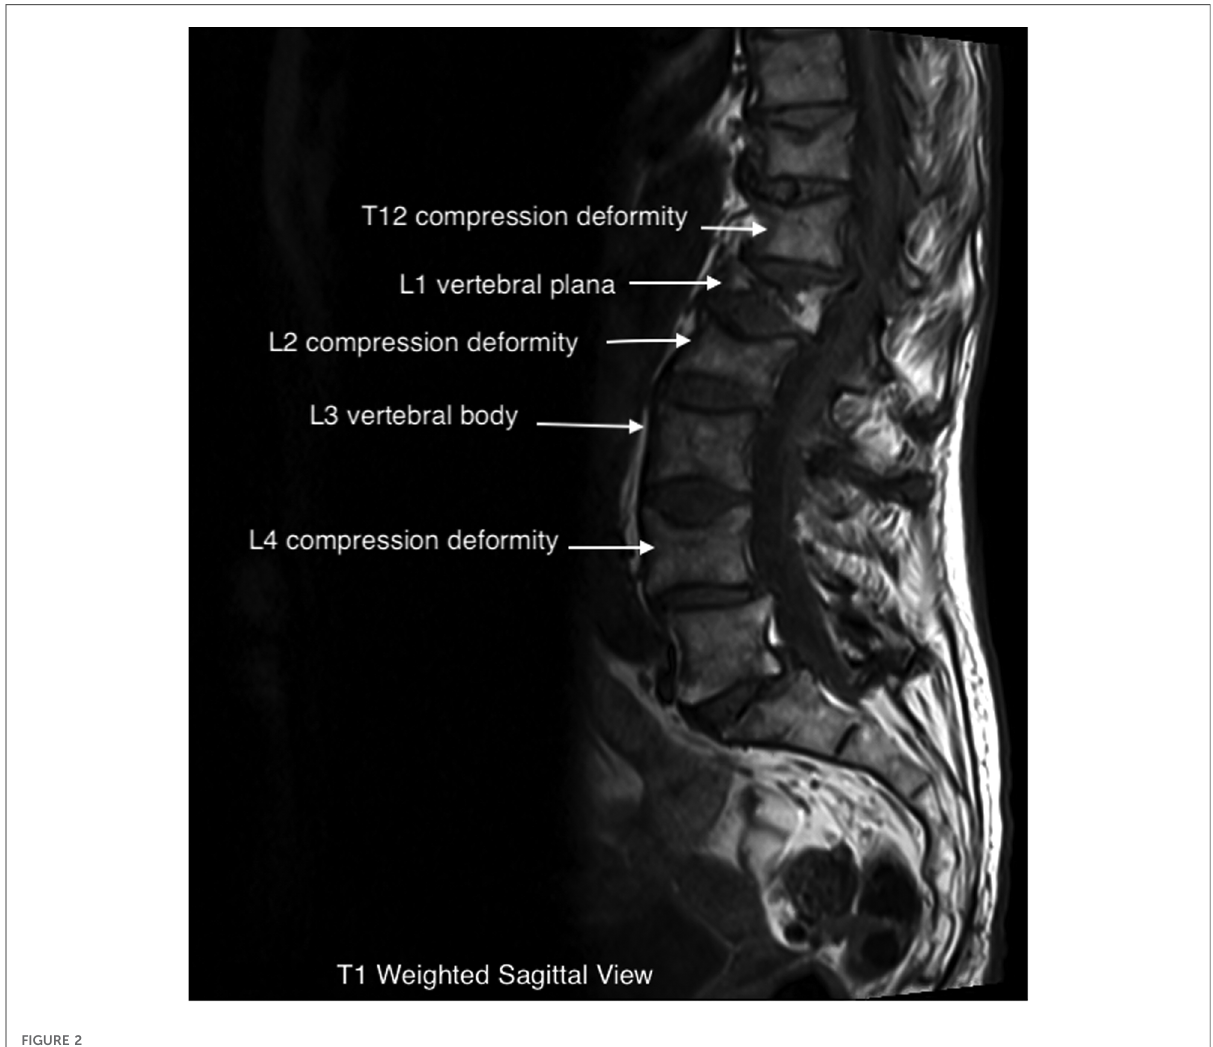
FIGURE 2 T1 weighted sagittal